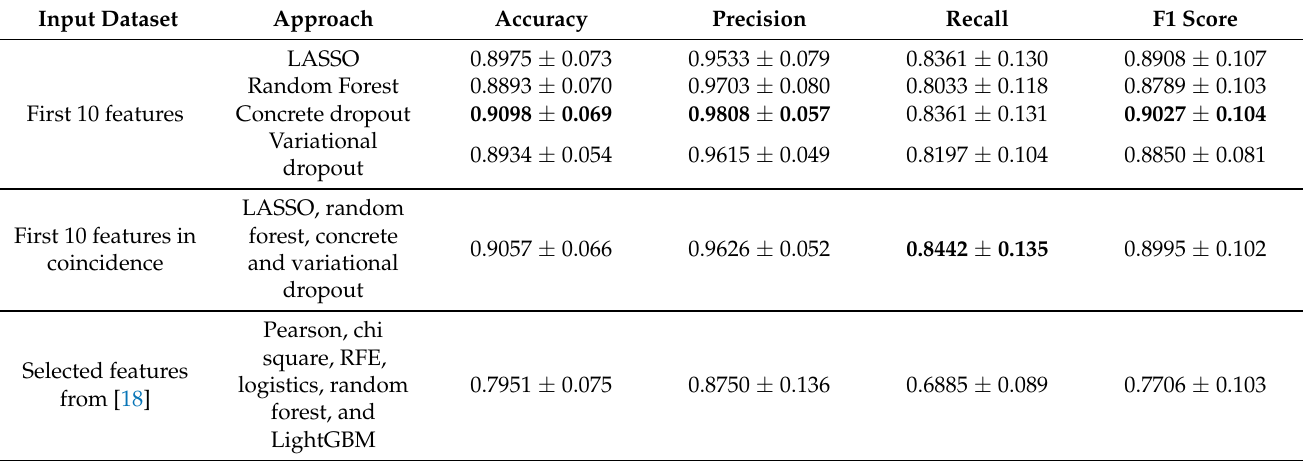
Table 6. Performance metrics of the approaches considered, according to the selected input features, in each experimental setting. The highest value for each performance metric is highlighted in